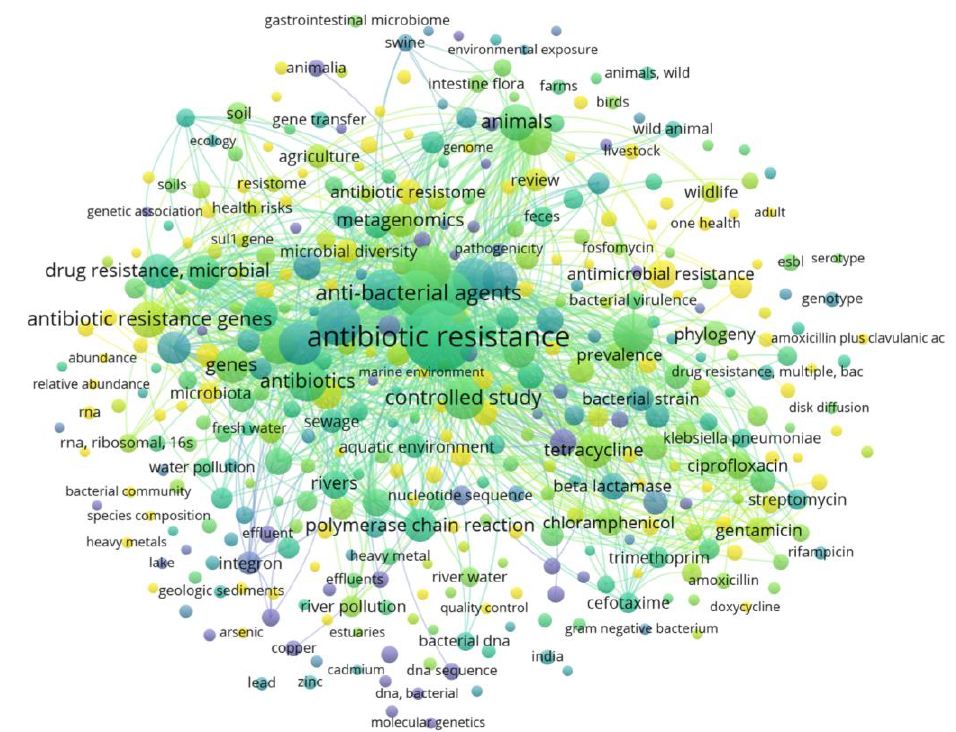
Figure 3. A keyword co-occurrence map, considering papers containing “antibiotic resistance” as a keyword. Circle size is proportional to the number of co-occurrences of a particular keyword and clustering by color is based on patterns of co-occurrence among multiple keywords in the published articles. The map was created with VOSviewer (v1.6.16; 2020, Centre for Science and Technology Studies, Leiden University, The Netherlands).